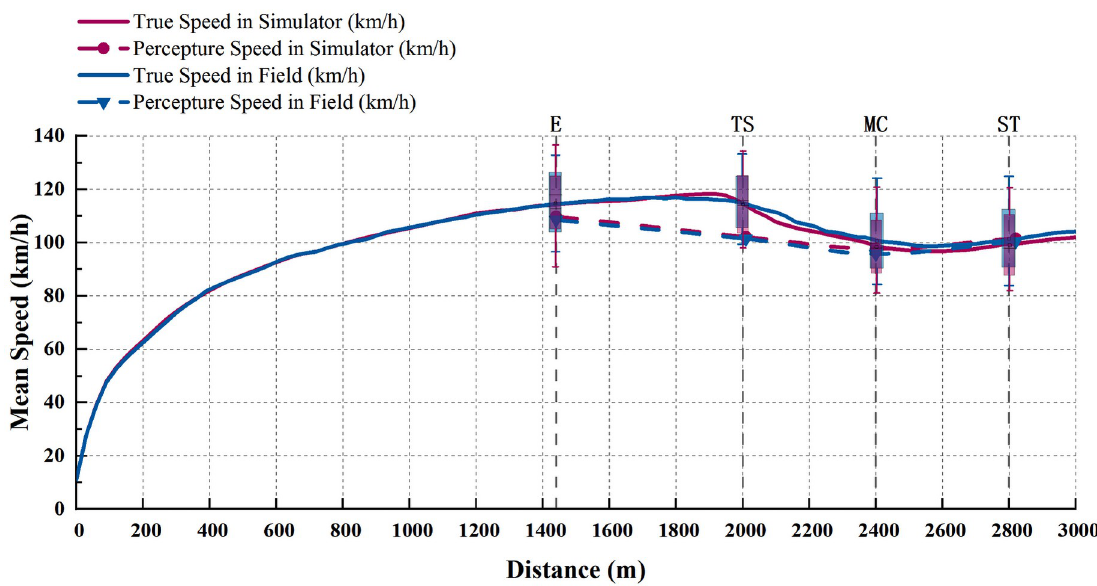
Fig 11. Comparison diagram of field and simulated mean speed data (The four longitudinal reference lines correspond to the perceived speed acquisition points: E, TS, MC, and